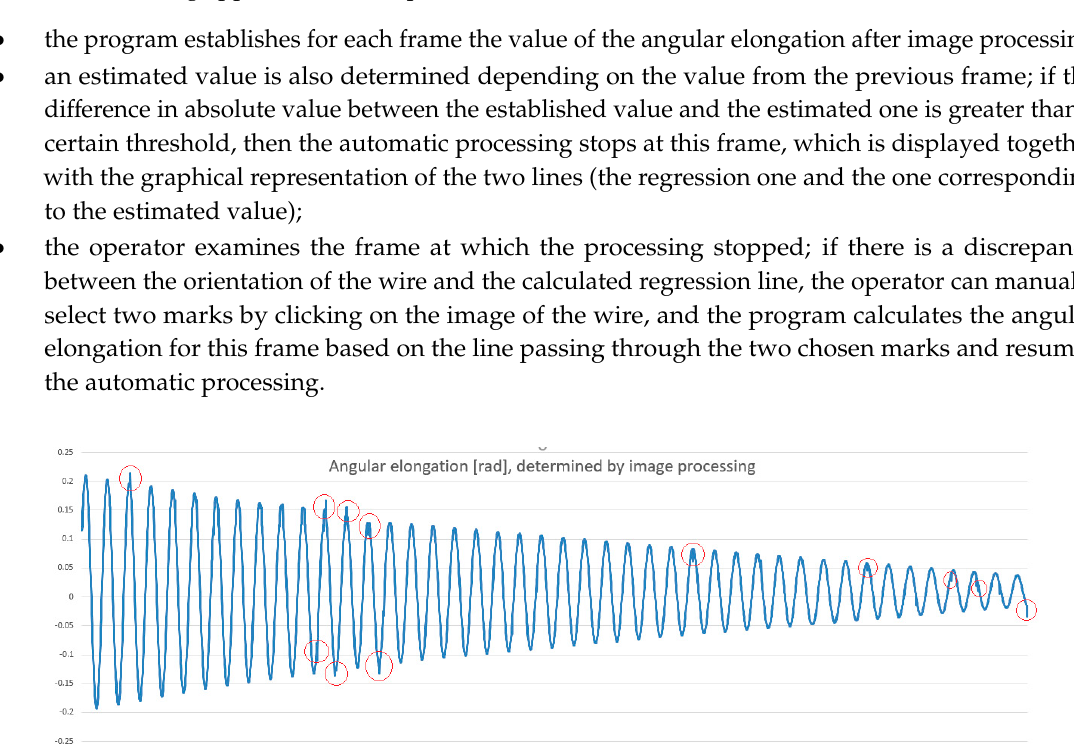
Figure 11. Experimental measurement of the angular amplitude of the pendulum.